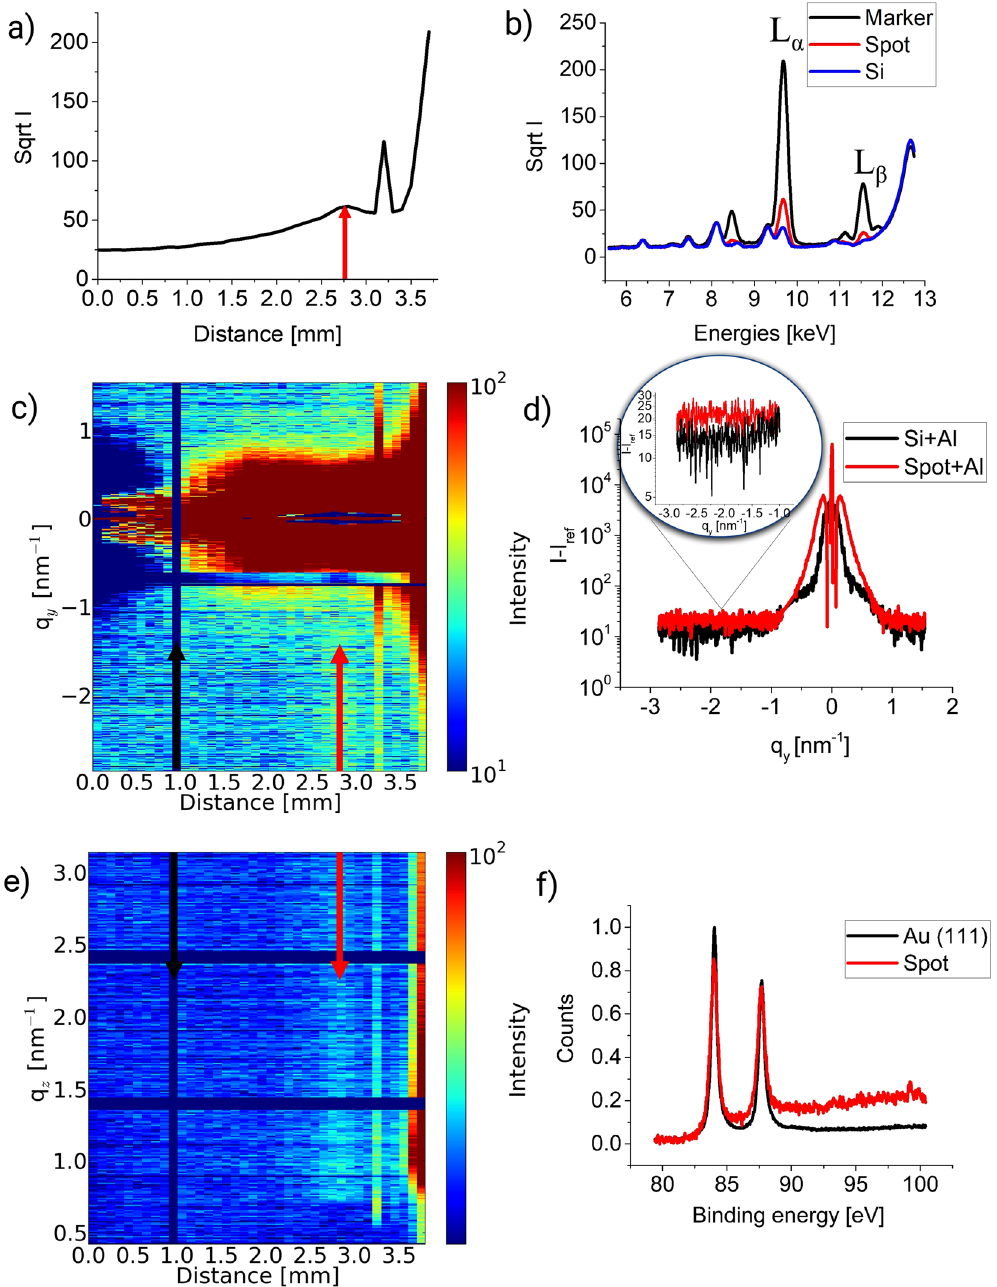
Figure 3. XRF, XPS and scattering data for the sample with deposited 10% ML material of Au 9 clusters. All plots have Al capping layer on top. Scanned area of the former sample is 3.8 mm of the 9 mm sample surface. ( a ) XRF spectra of the sample at the L α Au line as function of lateral distance on the Si surface. At a distance of 2.8 mm on x axis is the maximum of XRF signal stemming of the adatomic spot, on the right from it the sharp peak is an artefact and at 3.5 mm is an Au marker. ( b ) XRF spectra of the sample from energies for Au 9 spot (red), Au marker (black) and Si (blue). ( c ) Contour plot of the out-of-plane cuts (along q y ) derived at the Si Yoneda peak (q z = 0.7 nm − 1 ) for different positions on the substrate. The black arrow indicates the substracted data frame, the red one-the maximum of the Au 9 spot. ( d ) GISAXS out-of-plane (along q y ) line cuts at the position with the maximum amount of material obtained from the XRF data and the Si position. Red curve- Au 9 spot, black curve- Si. The inset shows the difference between the Si and Au signal. ( e ) Contour plot of off-detector (along q z ) line cuts at q y from − 2.1 to − 1.4 versus the position on the substrate. The black arrow indicates the subtracted data frame, the red one the maximum of the Au 9 spot. ( f ) XPS spectra for Au 9 spot and Au (111) crystal at Au 4f 7/2